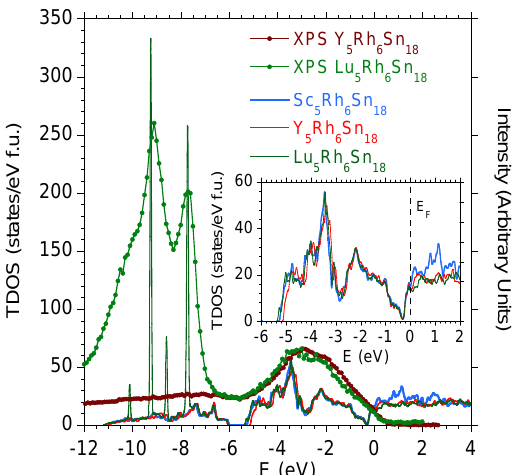
Figure 2. Valence band XPS spectra for Y 5 Rh 6 Sn 18 (brown points) and Lu 5 Rh 6 Sn 18 (green points) are compared with the TDOS calculated for R 5 Rh 6 Sn 18 ( R = Sc, Y, Lu) within the LSDA approximation. The intensities of the measured VB XPS spectra are renormalised to the same background either of the R = Y or R = Lu samples at energies E > (cid:101) F